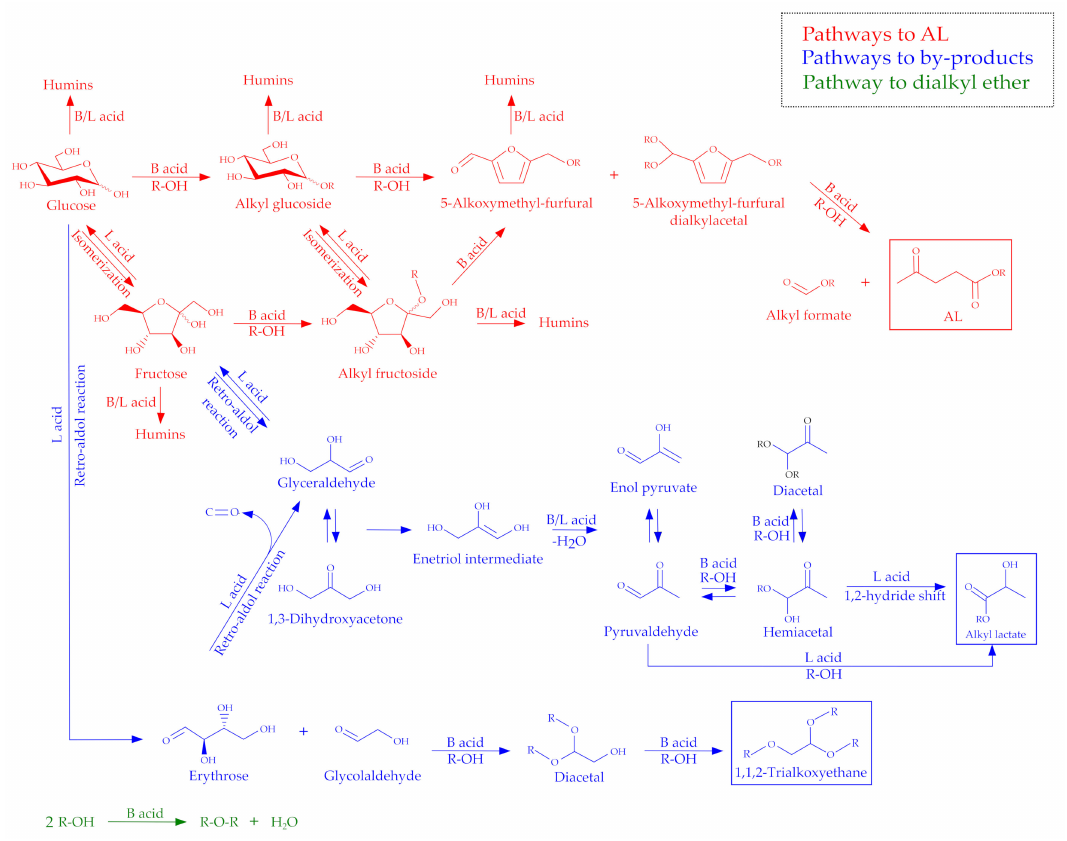
Figure 3. Possible pathways for the glucose alcoholysis, depending on the Brønsted (B) and Lewis (L)